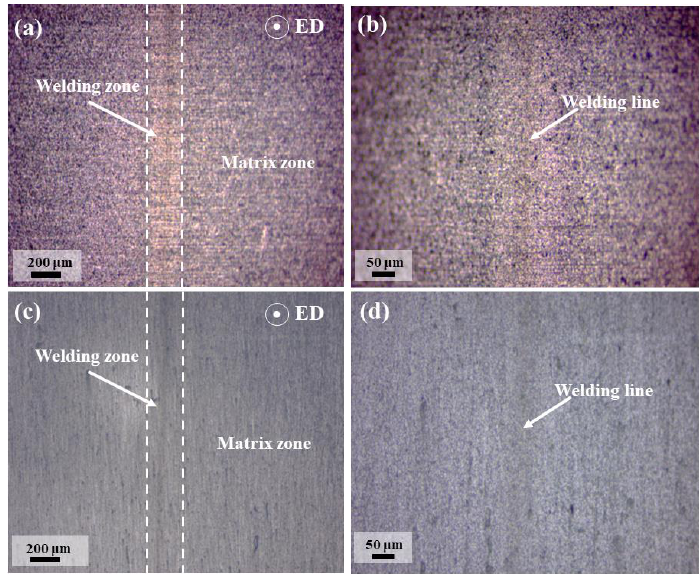
Figure 7. Optical microstructure near the welding zone on the cross-section of the extrudates: ( a , b ) composite; ( c , d ) pure aluminum.